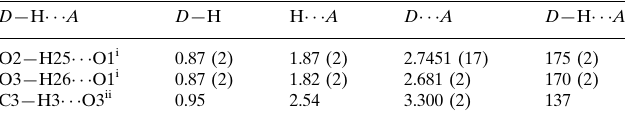
Hydrogen-bond geometry (A˚ , (cid:2)